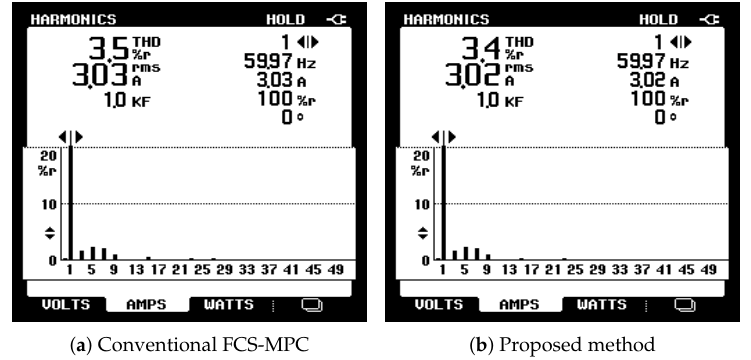
Figure 17. THD of grid current.